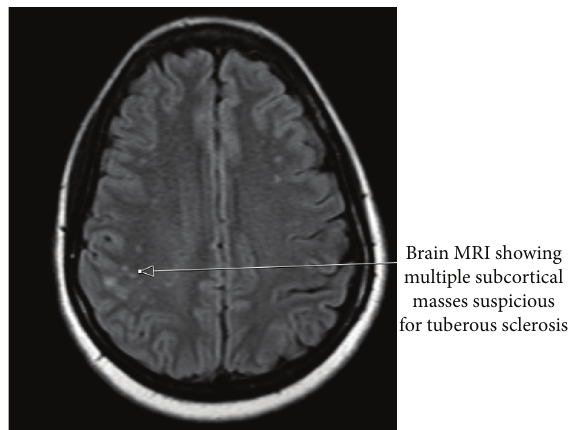
Figure 3: Brain MRI, showing subcortical masses.